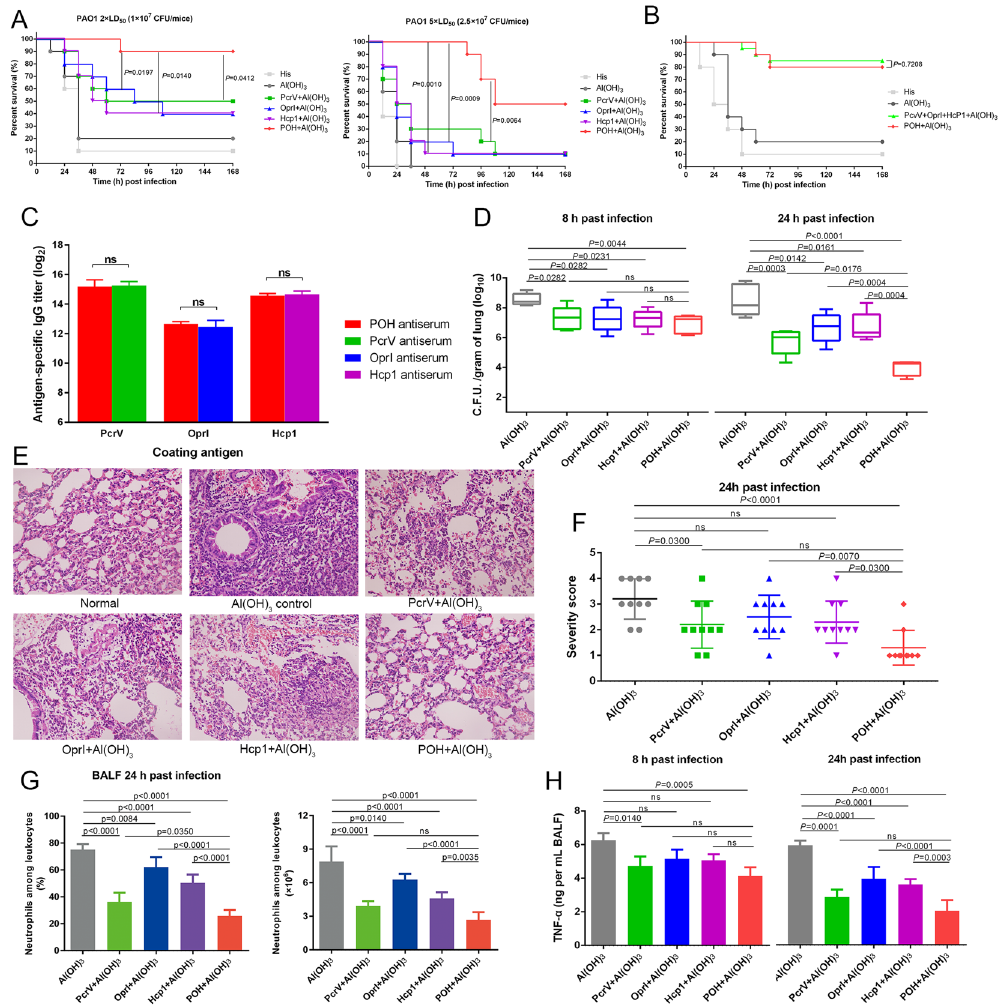
Figure 3. Protective efficacy of POH in murine P . aeruginosa pneumonia model. ( A ) BALB/c mice (n = 10) were immunized with antigens (PcrV, OprI, Hcp1 and POH) plus an Al(OH) 3 adjuvant and challenged with PAO1 at 2 × LD 50 (1.0 × 10 7 CFUs/mouse, left panel) or 5 × LD 50 (2.5 × 10 7 CFUs/mouse, right panel) by intratracheal injection. The survival rate was monitored for 1 week. ( B ) BALB/c mice (n = 20) were immunized with a trivalent POH vaccine or a mixture including PcrV, OprI, and Hcp1. The mice were challenged with PAO1 at 1.0 × 10 7 CFUs/mouse by intratracheal injection, and the survival rate was monitored for 1 week. ( C ) Plates were coated with OprI, PcrV, and Hcp1, respectively. And serum was collected from mice (n = 10) in ( A ) immunized with antigens (PcrV, OprI, Hcp1 and POH) plus Al(OH) 3 adjuvant on day 28 before challenge. Antibody responses were expressed as the mean of log 2 titers. Student’s t-test was used to compare values. (ns = no significance). Data were shown as the mean ± SEM. ( D – H ) The immunized mice and control mice were infected intratracheally with 5.0 × 10 6 CFUs/mouse of PAO1. ( D ) The number of viable bacteria in the lungs of mice (n = 10) at 8 h and 24 h post-infection are shown. ( E ) Hematoxylin-eosin staining of lungs from immunized mice and control mice 24 hours after infection. Representative histopathological sections from 10 mice per group are shown (magnification = 200X). ( F ) Semi-quantification of lung inflammation in infected mice. Severity scores of lungs (n = 10) from immunized mice and control mice 24 hours post- infection are shown. The data are presented as scatter plots. ( G ) Evaluation of neutrophil infiltration in infected mice (n = 10). The bar represents the percentage (left) and the number (right) of neutrophils in the BALF of immunized mice (n = 10) at 24 hours post-challenge. ( H ) Quantitative detection of proinflammatory cytokines (TNF- α ) in infected mice (n = 10). The data ( D , F , G and H ) were shown as the mean ± SD. The P-value ( A and B ) was calculated using the Mantel-Cox log-rank test. Multiple comparisons among different groups ( D , F , G and H ) were calculated using one-way ANOVA (ns = no